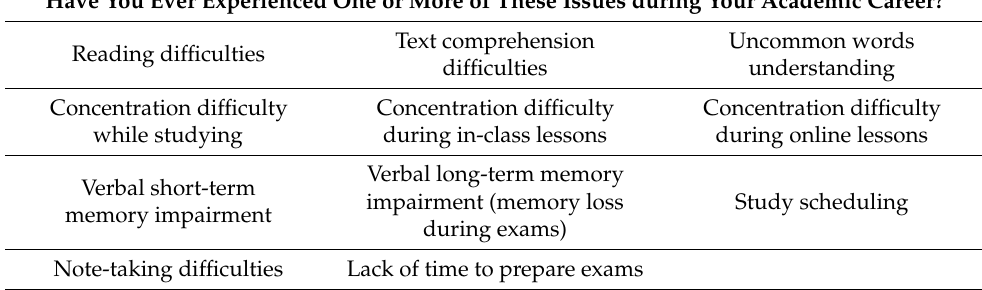
Table 3. List of the questions about the most useful supporting tools for dyslexic students, asked within the BESPECIAL questionnaire.